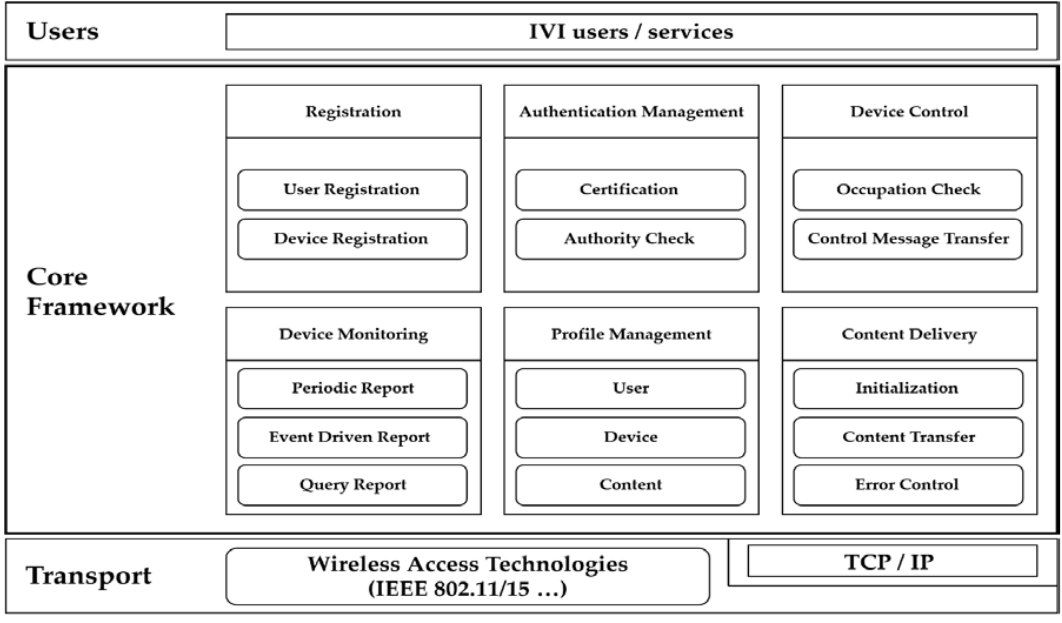
Figure 5. A-IVI functional blocks .